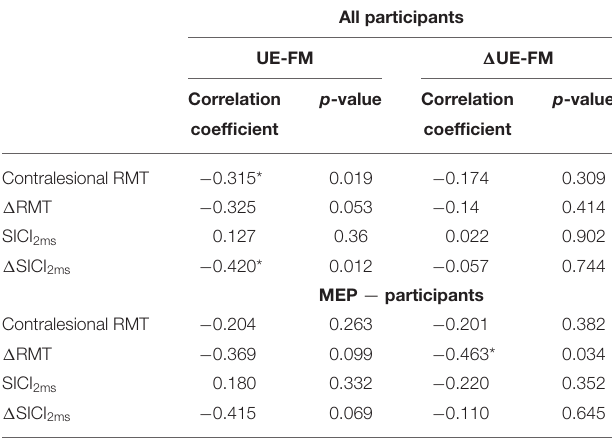
TABLE 2 | Correlation between UE-FM and corticospinal excitability in the contralesional M1. All participants UE-FM 1